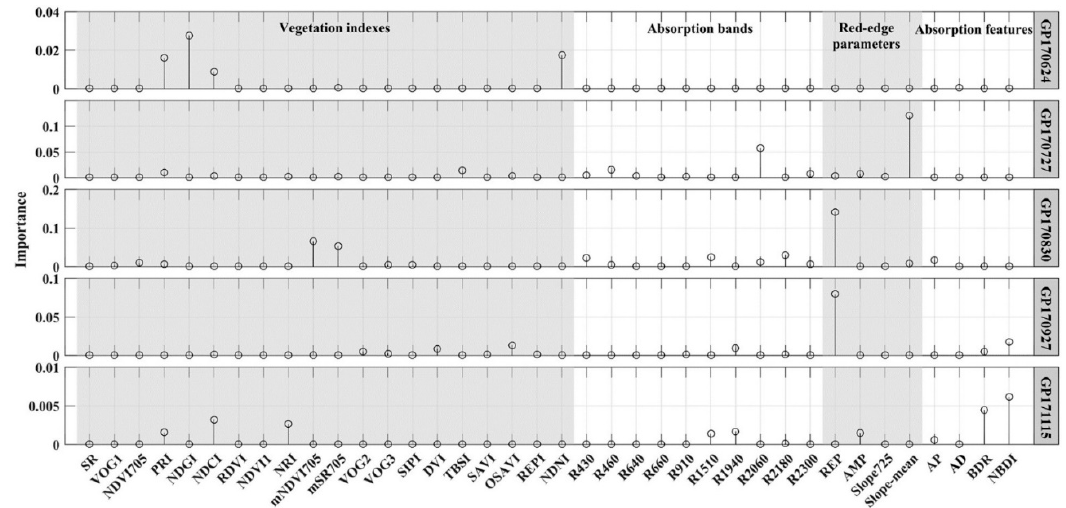
Figure 5. Measured importance of spectral variables for estimating the forage N during different growth periods (higher variable importance corresponds to the greater importance of the variable for estimating forage N).